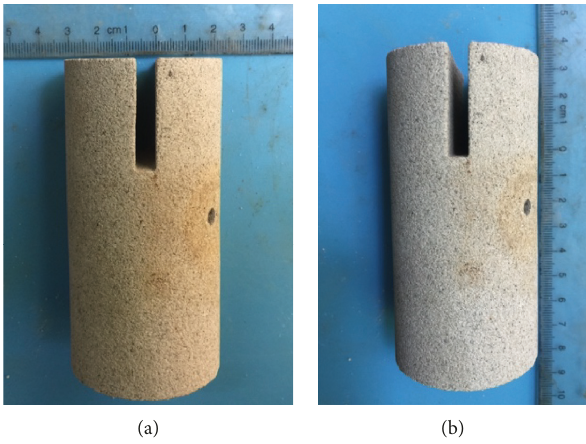
Figure 3: Prefabricated crack: 6 mm width and 25%